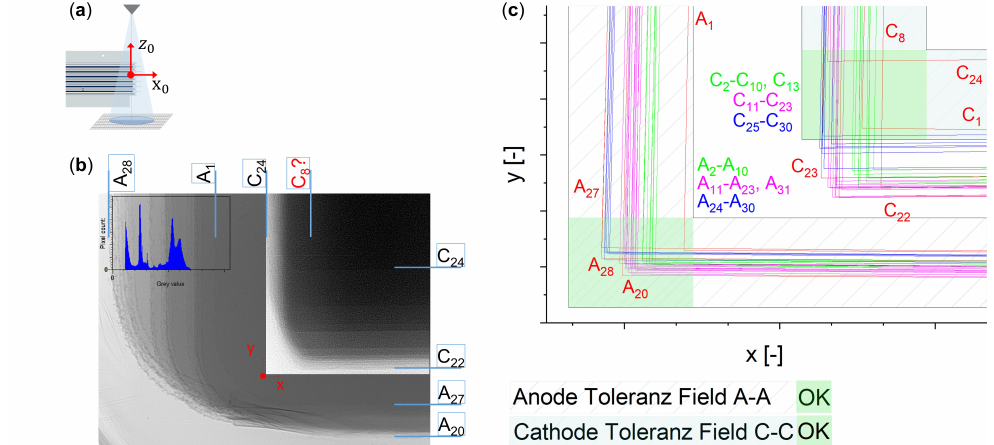
Figure 6. Sketch ( a ) shows the experimental setup for a vertical beam direction of the ESC corner in z 0 -direction and the corresponding X-ray image is shown in ( b ). The diagram in ( c ) illustrates the linear fit of the electrode edges with the CT data in y 0 - and x 0